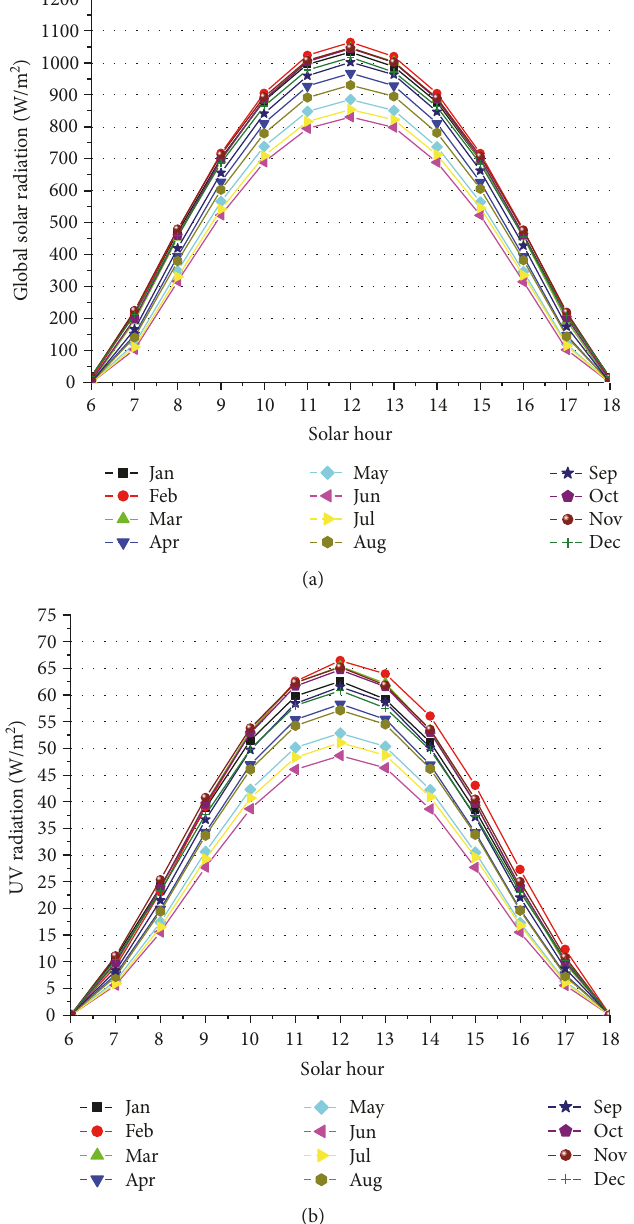
Figure 3: Daily pro fi les of global solar radiation (a) and UV (A +B) radiation (b) estimated with SPECTRAL2 for a clear sky day throughout the months of the